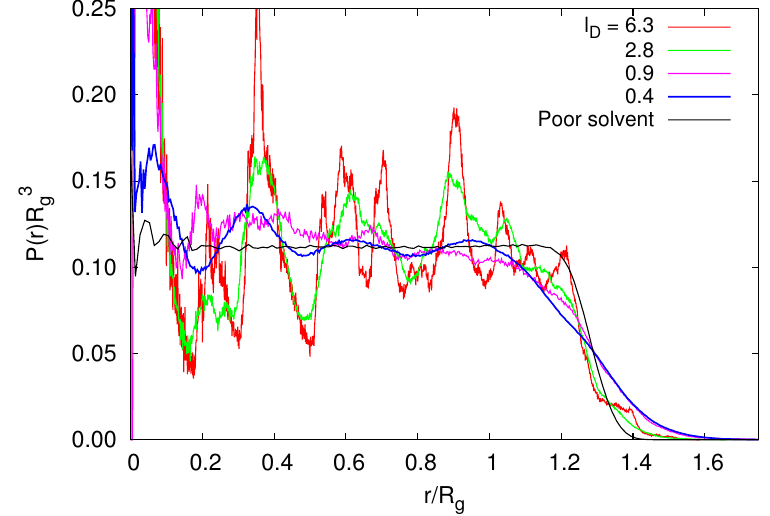
Figure 9. Radial monomer distribution functions for various Debye lengths, l N = 40 and l /l = 5 . In addition, P ( r ) for (cid:15)/k m B is